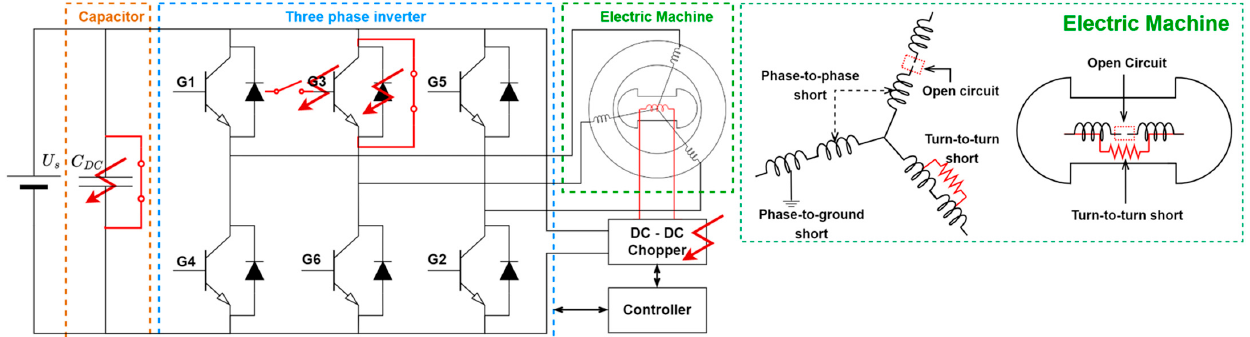
Figure 2. Representation of various possible faults in EV powertrain.